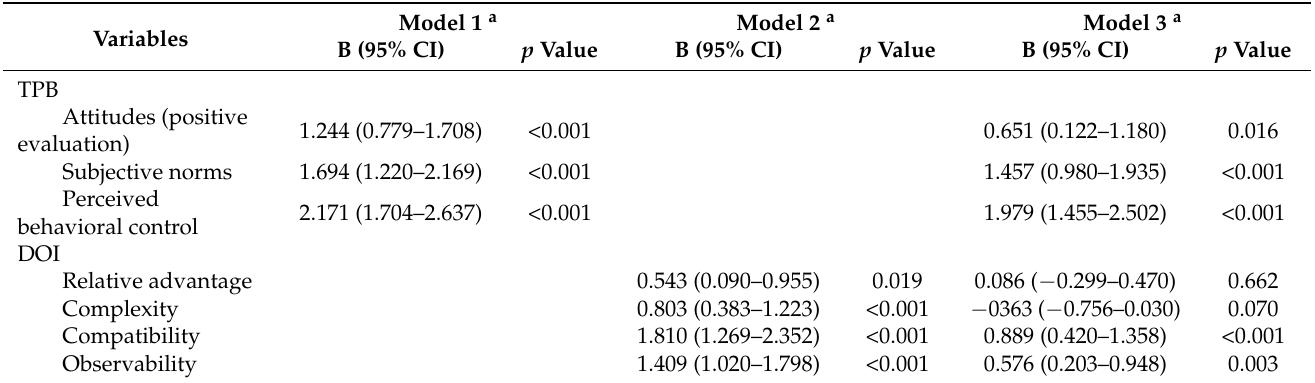
Table 5. Multiple analysis of willingness to use wearable health